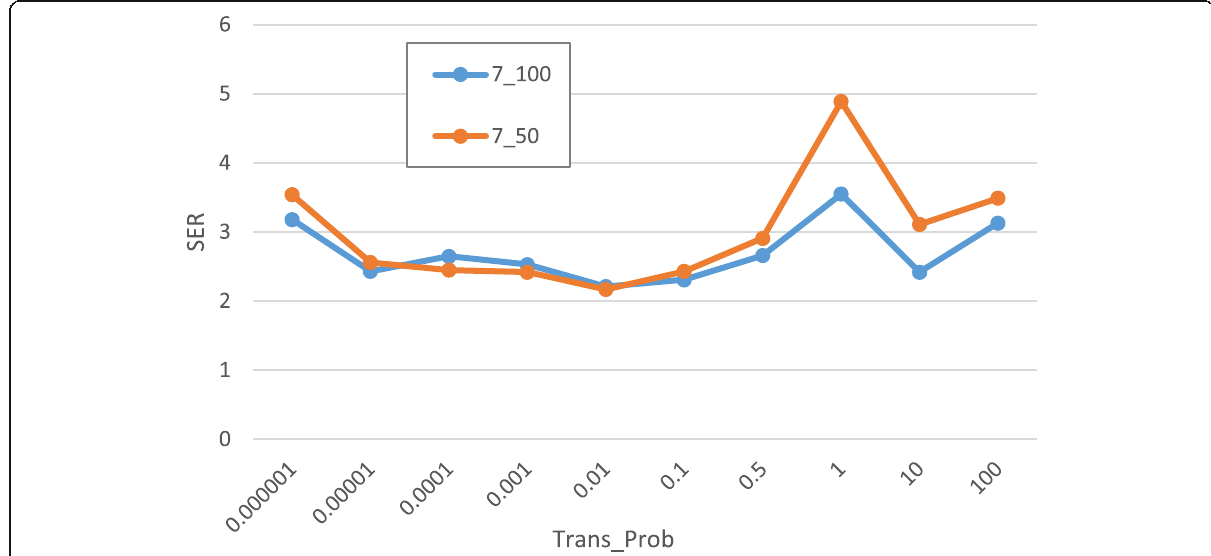
Fig. 16 SER across transition weight K for the DEVELSET for two working points used in previous section 7-100 and 7-50 and minimum duration